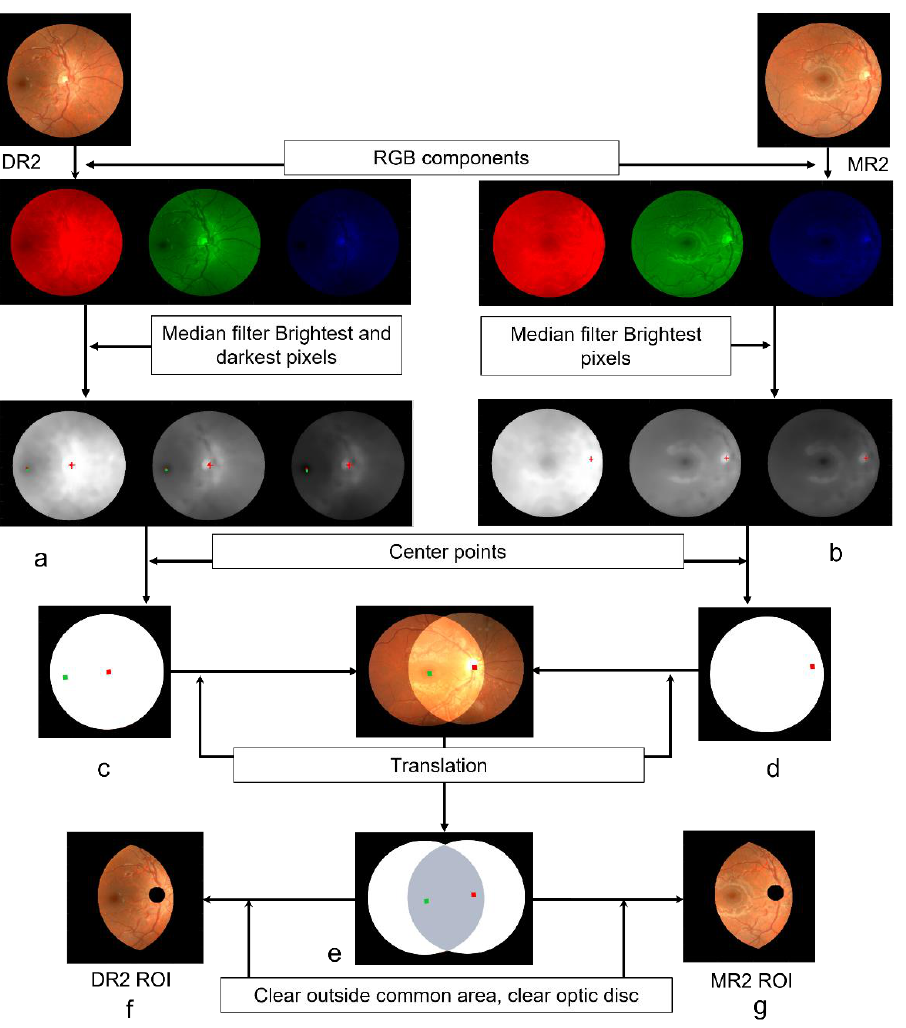
Figure 3. Determination of the ROI for DR2 and MR2. Brightest (red) points in all three RGB components of ( a ) DR2; ( b ) MR2. Darkest points are marked in green in ( a ). Optic disc midpoint (red) in ( c ) DR2; ( d ) MR2. Macula midpoint is marked in green in ( c ). ( e ) Intersection and common area (grey shaded) of DR2 and MR2. ( f ) ROI of DR2. ( g ) ROI of MR2. (See the text for more details).